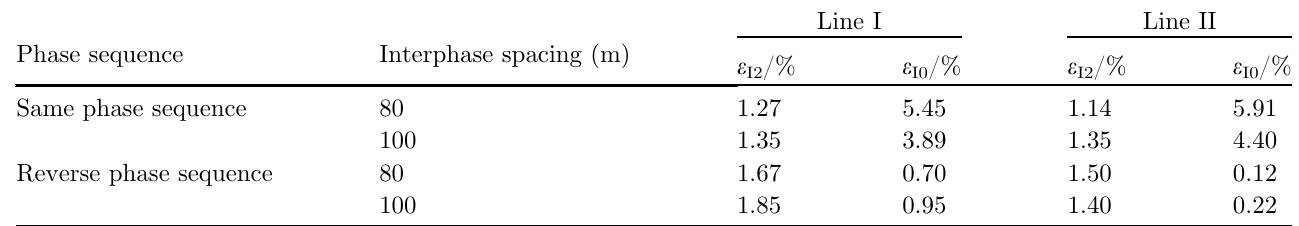
Table 5. In fl uence of distance between circuits on current unbalance. Phase